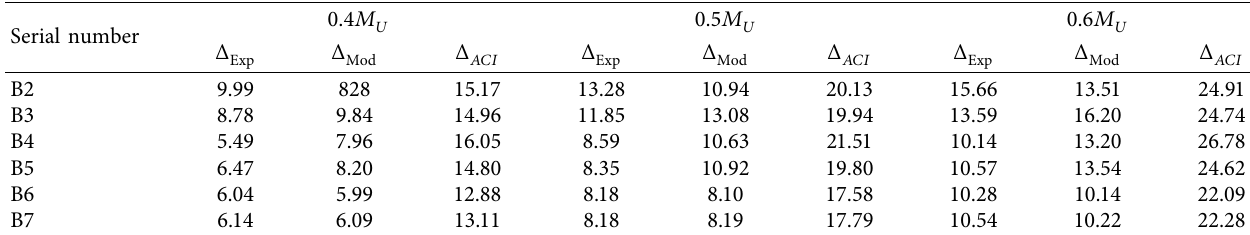
Table 4: Calculated and tested